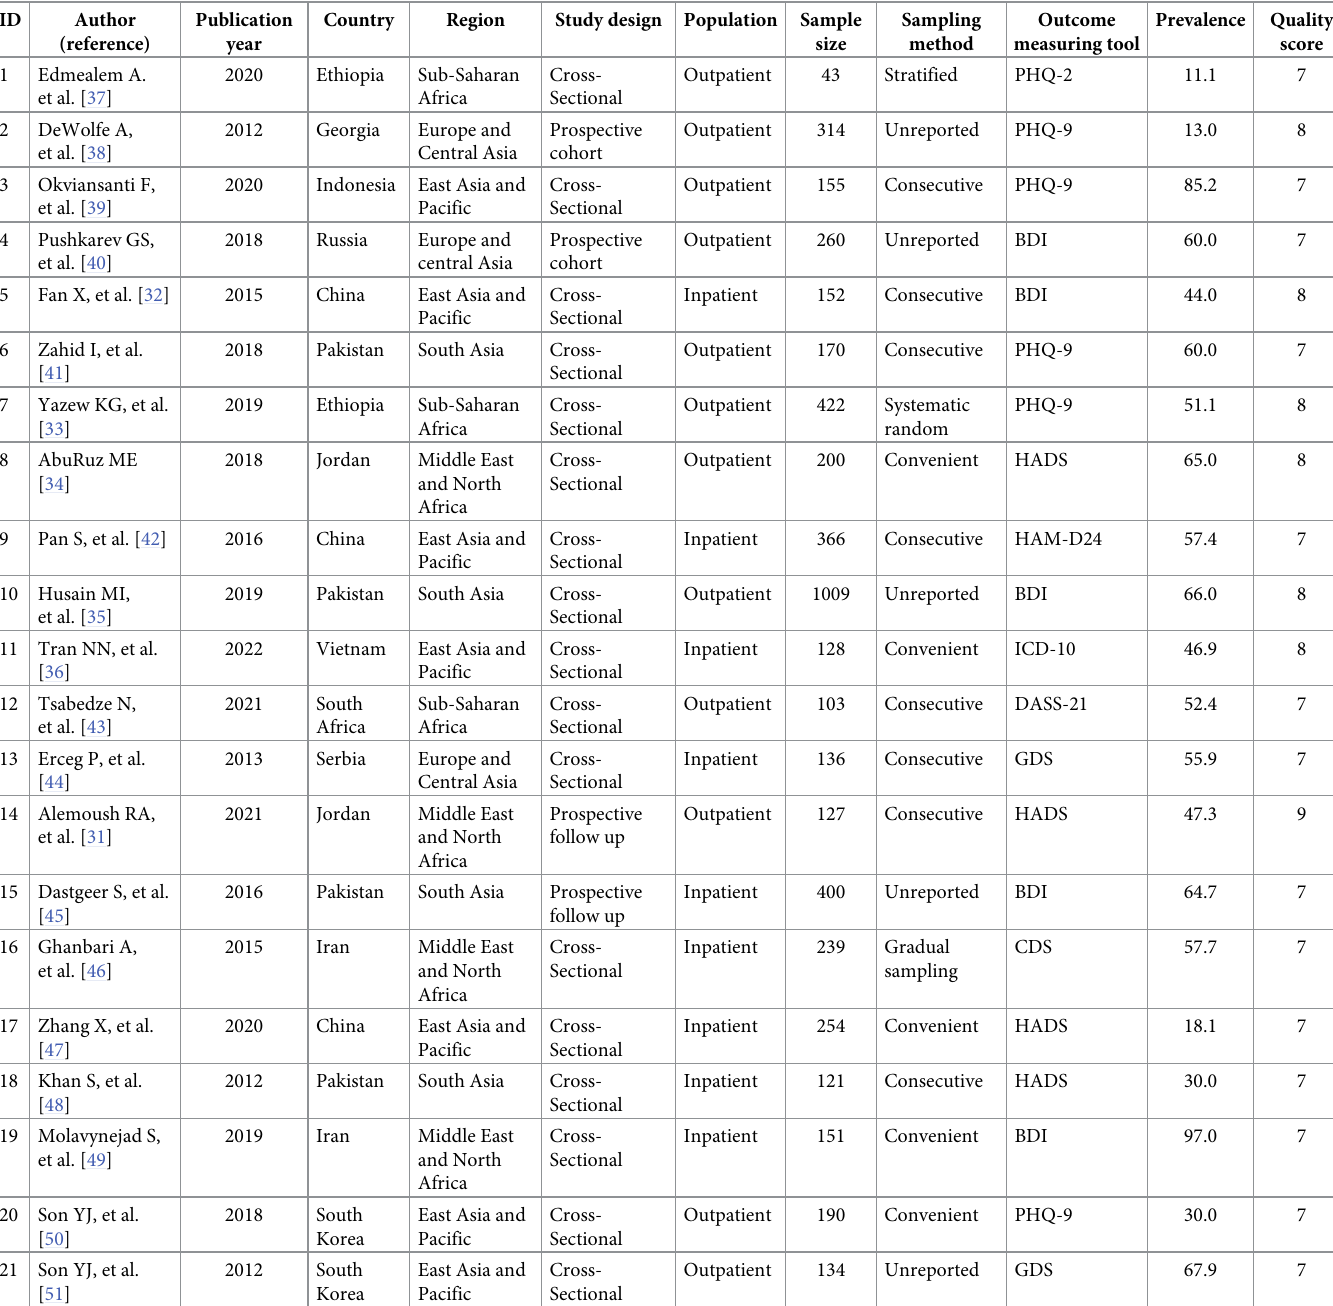
Table 2. Characteristics of included studies for prevalence of depression among people with heart failure in